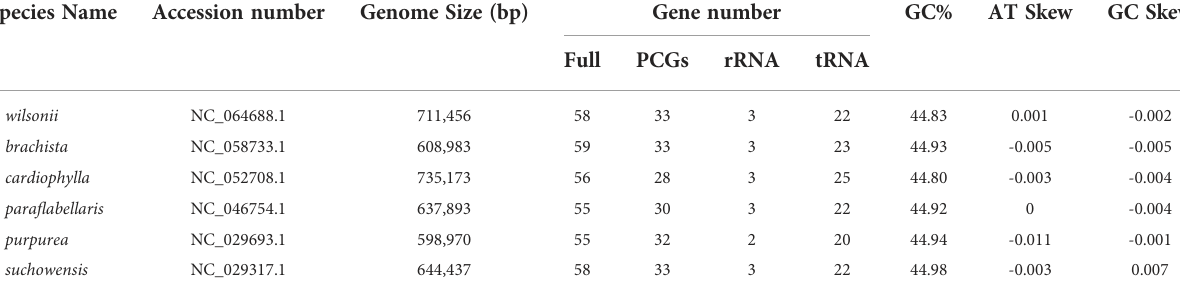
TABLE 1 Genomic features of six Salix mitogenomes.